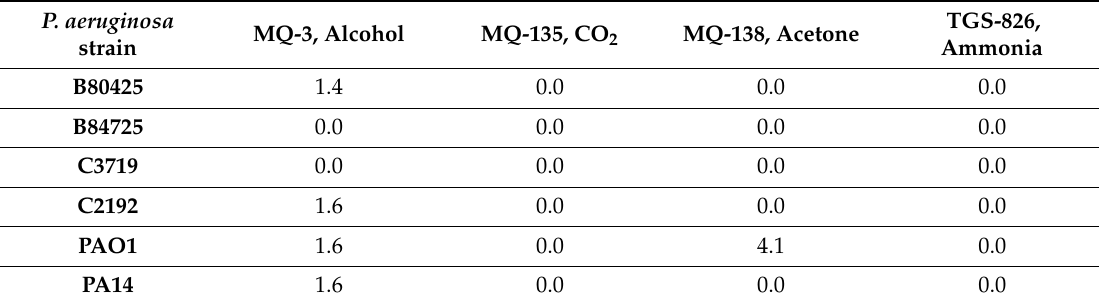
Table A6. Mean values of the P. aeruginosa liquid samples at 7.5